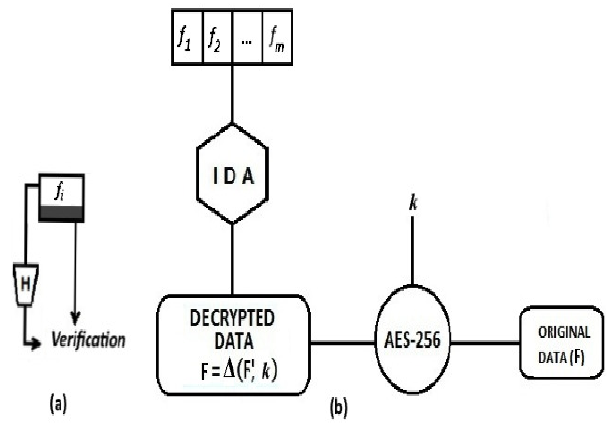
Figure 3. Decoding steps: ( a ) Verification step; ( b ) reconstruction